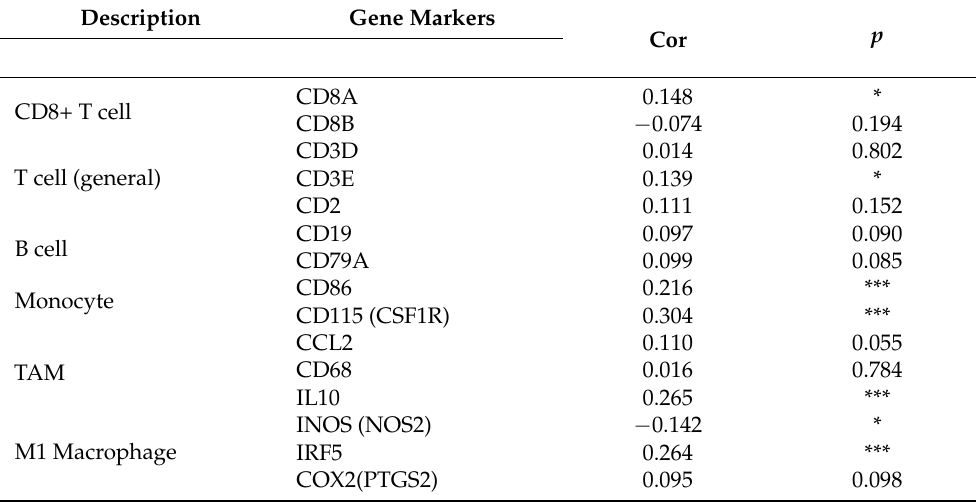
Figure 6. Correlations between ADCY7 expression and various immune inhibitors in cervical cancer. ( A ) Heat map ( B ) Scatter plo t , such as PDCD1LG2, CTLA4, TIGIT, TNFRSF14, TNFRSF25, CD40, LAIR1, LGALS9, ADORA2A, ICOS, CD276, and TNFSF4 in cervical cancer that are available in the TISIDB database. Table 3. Correlation analysis between ADCY7 and related genes and markers of immune cells of CESC in the Tumor Immune Estimation Resource (TIMER2.0).